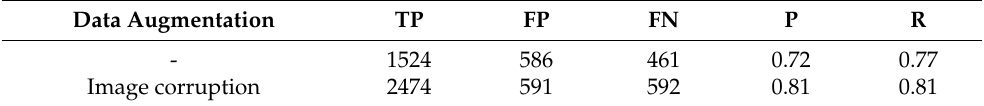
Table 1. Test Results of YOLOv3 on TT100K after Applying Data Augmentation Technology.